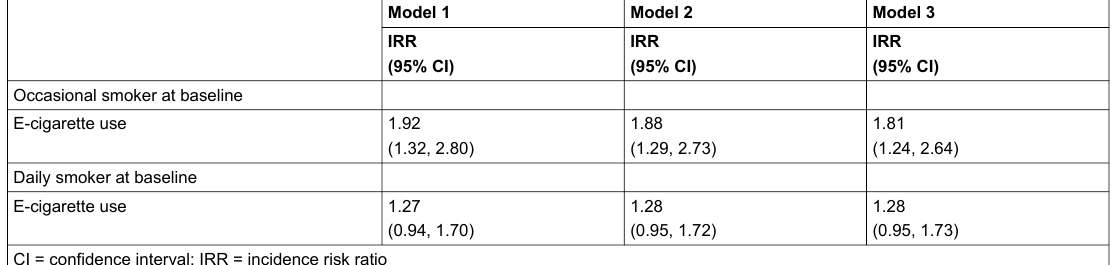
Table 5: Negative binomial regression models of the number of attempts to stop smoking on e-cigarette use (measured at follow-up only), stratified by cigarette smoking at baseline, Switzerland